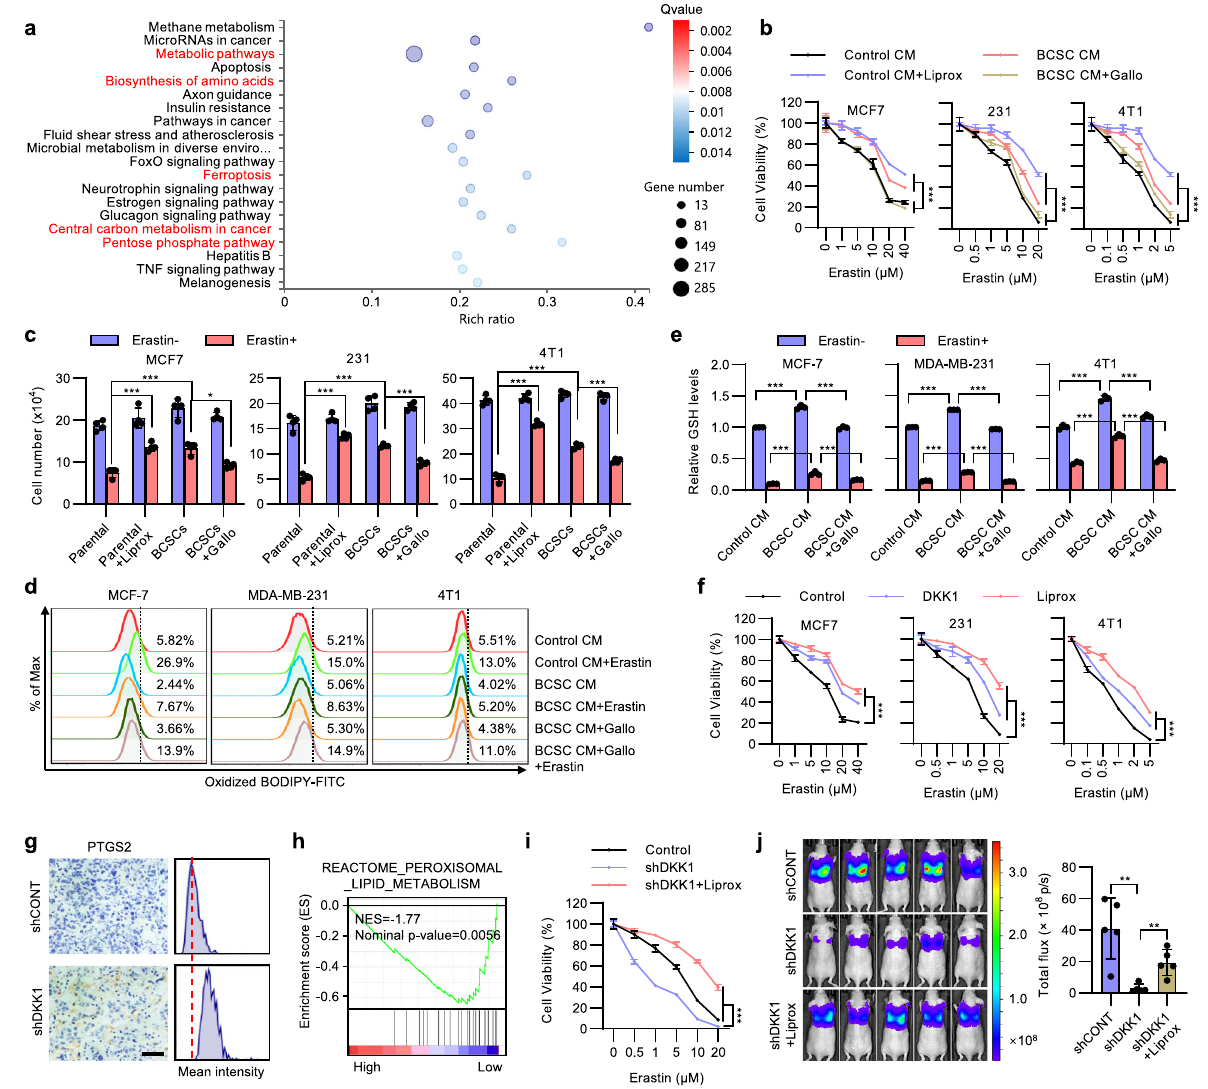
Fig. 5 BCSC secretome confers ferroptosis resistance. a KEGG analysis of the most enriched pathways in MCF-7 cells cultured with CM from BCSCs or parental cells. b Cell viability of MCF-7, MDA-MB-231 or 4T1 cells cultured with respective control CM ± 1 μ M Liproxstatin-1 or BCSC CM ± 5 μ M Gallocyanine and treated with a graded concentration of Erastin. c MCF-7, MDA-MB-231 or 4T1 cells were co-cultured with respective parental cells ± 1 μ M Liproxstatin-1 or BCSCs ± 5 μ M Gallocyanine and treated with 10 μ M (MCF-7), 5 μ M (MDA-MB-231), and 1 μ M (4T1) Erastin, respectively. Cell viability was determined by cell count assay. d Lipid ROS in MCF-7, MDA-MB-231, or 4T1 cells cultured with respective control CM or BCSC CM for 48 h in the presence or absence of 5 μ M Gallocyanine and treated with 10 μ M (MCF-7), 5 μ M (MDA-MB-231), and 1 μ M (4T1) Erastin, respectively. e Relative GSH levels in MCF-7, MDA-MB-231, or 4T1 cells cultured with respective control CM or BCSC CM ± 5 μ M Gallocyanine and treated with Erastin for 48 h. f Cell viability of MCF-7, MDA-MB-231, or 4T1 cells were cultured with 100 ng/ml recombinant DKK1 or 1 μ M Liproxstatin-1 and treated with a graded concentration of Erastin for 48 h. g IHC staining of PTGS2 in lung metastases derived from MDA-MB-231-shCONT or -shDKK1 cells. Scale bar: 50 μ m. h GSEA analysis of the enrichment of peroxisomal lipid metabolism in TCGA breast cancer patients with different DKK1 levels. i Cell viability of MDA-MB- 231-shCONT or -shDKK1 cells ± 1 μ M Liproxstatin-1 and treated with a graded concentration of Erastin for 48 h. j BLI of nude mice intravenously injected with 1 × 10 6 MDA-MB-231-shCONT or -shDKK1 cells and treated with vehicle or Liproxstatin-1 as indicated. Results are shown as mean ± S.D. * P < 0.05; ** P < 0.01; *** P < 0.001; ns not signi fi cant (Two-way ANOVA test in ( b , f , i ) unpaired two-tailed Student ’ s t test in ( j ), others one-way ANOVA followed